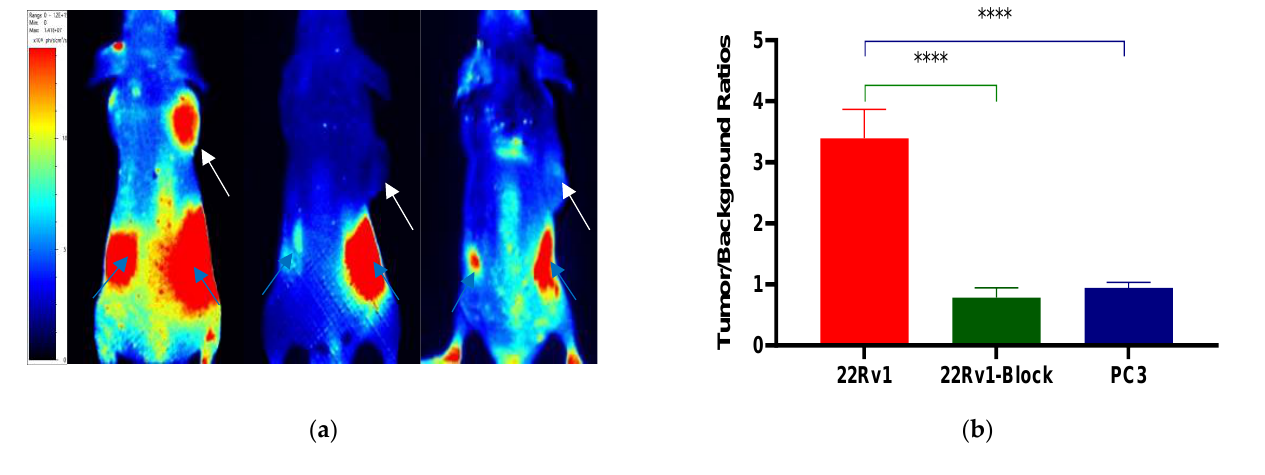
Figure 7. TBR analysis of in vivo fluorescence imaging. ( a ) Fluorescence imaging 60 min after injection of PSMA-Cy5 into the right shoulder of a tumor-bearing mouse (left). After 2-PMPA blockade, tumor uptake of PSMA-Cy5 was measured (middle). Fluorescence imaging of a PC3 tumor-bearing mouse on the right shoulder 60 min after injection of PSMA-Cy5 via the tail vein (right). ( b ) 22Rv1 nonblocking group or blocking group and PSMA (-) PC3 tumors, based on the TBR of the ROI analysis of PSMA-Cy5 uptake at 60 min (****: p < 0.0001).